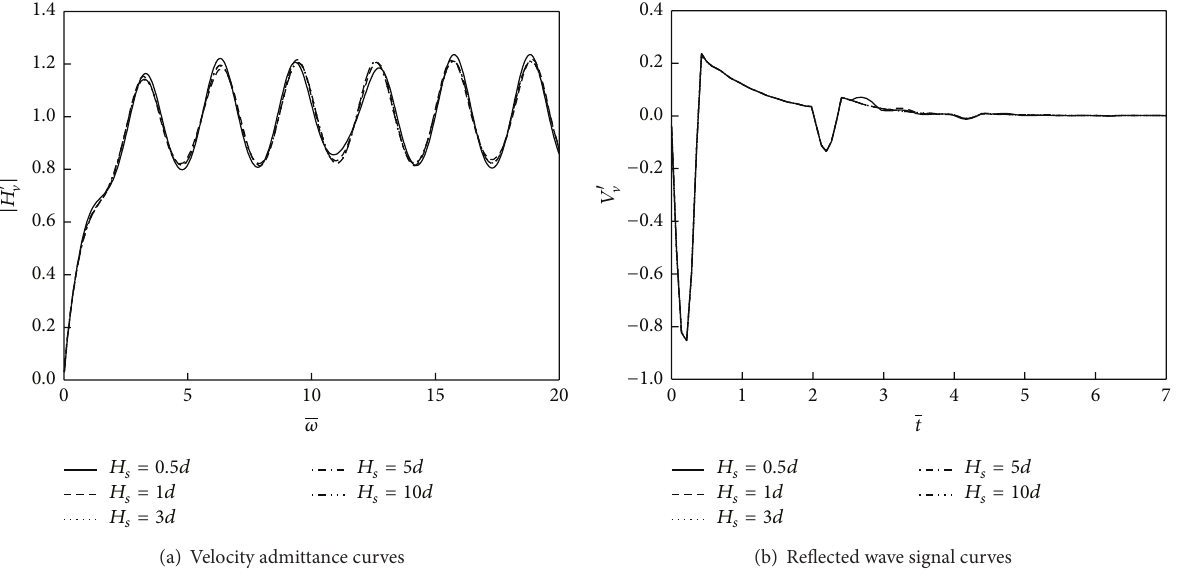
Figure 6: Influence of thickness of pile end soil on the dynamic response at pile head when 𝑉 𝑝,2 = 3600 m / s.